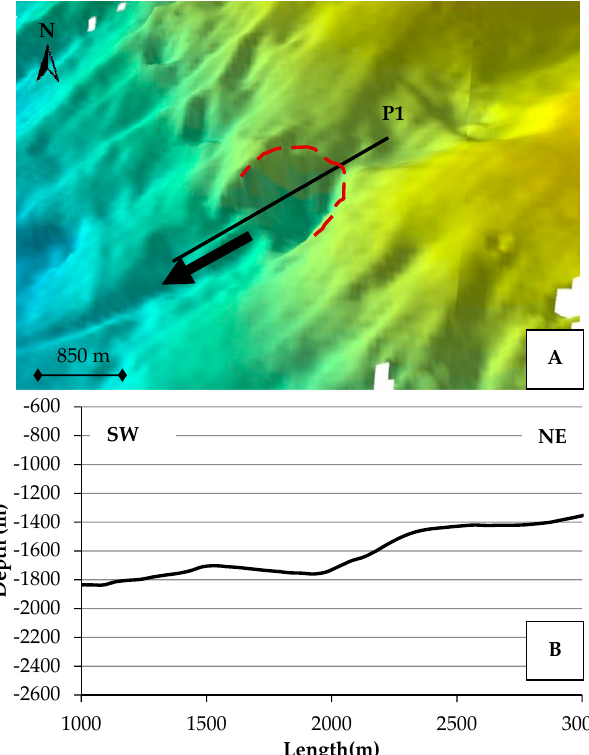
Figure 4. ( A ) Detail of a rotational slide (slump) along the canyon slope in 3D view highlighted with a red line. Black arrow indicates down slope movement. ( B ) NE–SW profile on the canyon slope, transversal to the rotational slide. Location of the P1 profile is in Figure